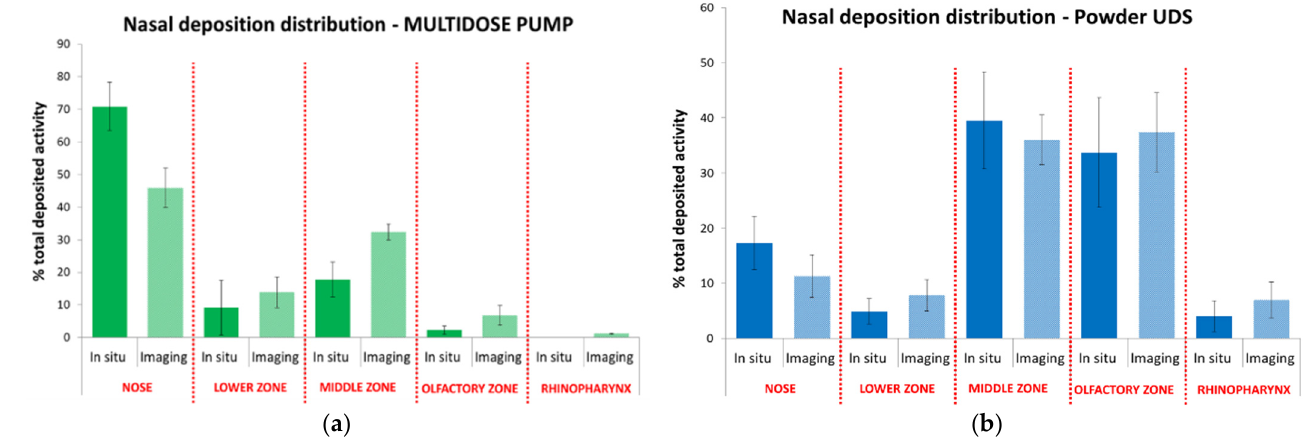
Figure 5. Percent deposition from a multi-dose aqueous nasal spray ( a ) and a unit dose (UDS) nasal powder ( b ). Deposition in the nasal cast trended with in vivo deposition as measured by gamma scintigraphy. (Dark green/Dark blue = in situ deposition with Fluorescein, Light green/Light blue = deposition by gamma scintigraphy).